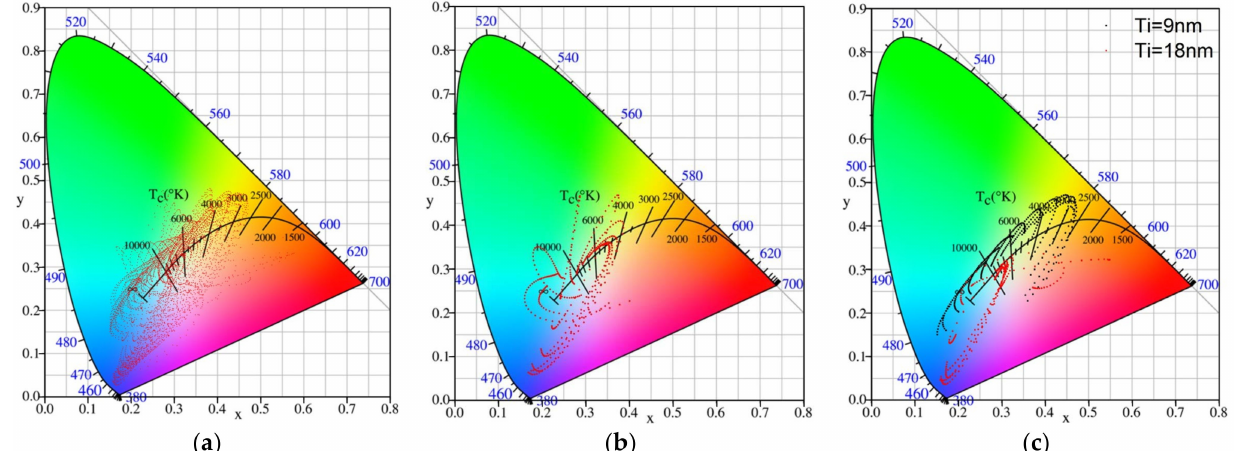
Figure 2. ( a ) Chromaticity (x,y) of the Al2O3/Ti/Al2O3/Ti multilayer stacks with a PTCE of more than 90% showing the chromaticity coordinates and the chromaticity ( x , y ) distribution when the second layer has thicknesses of ( b ) 15, ( c ) 9 and 18 nm. Five designed points for a wider color gamut are also shown in the chromaticity coordinate diagram in ( b